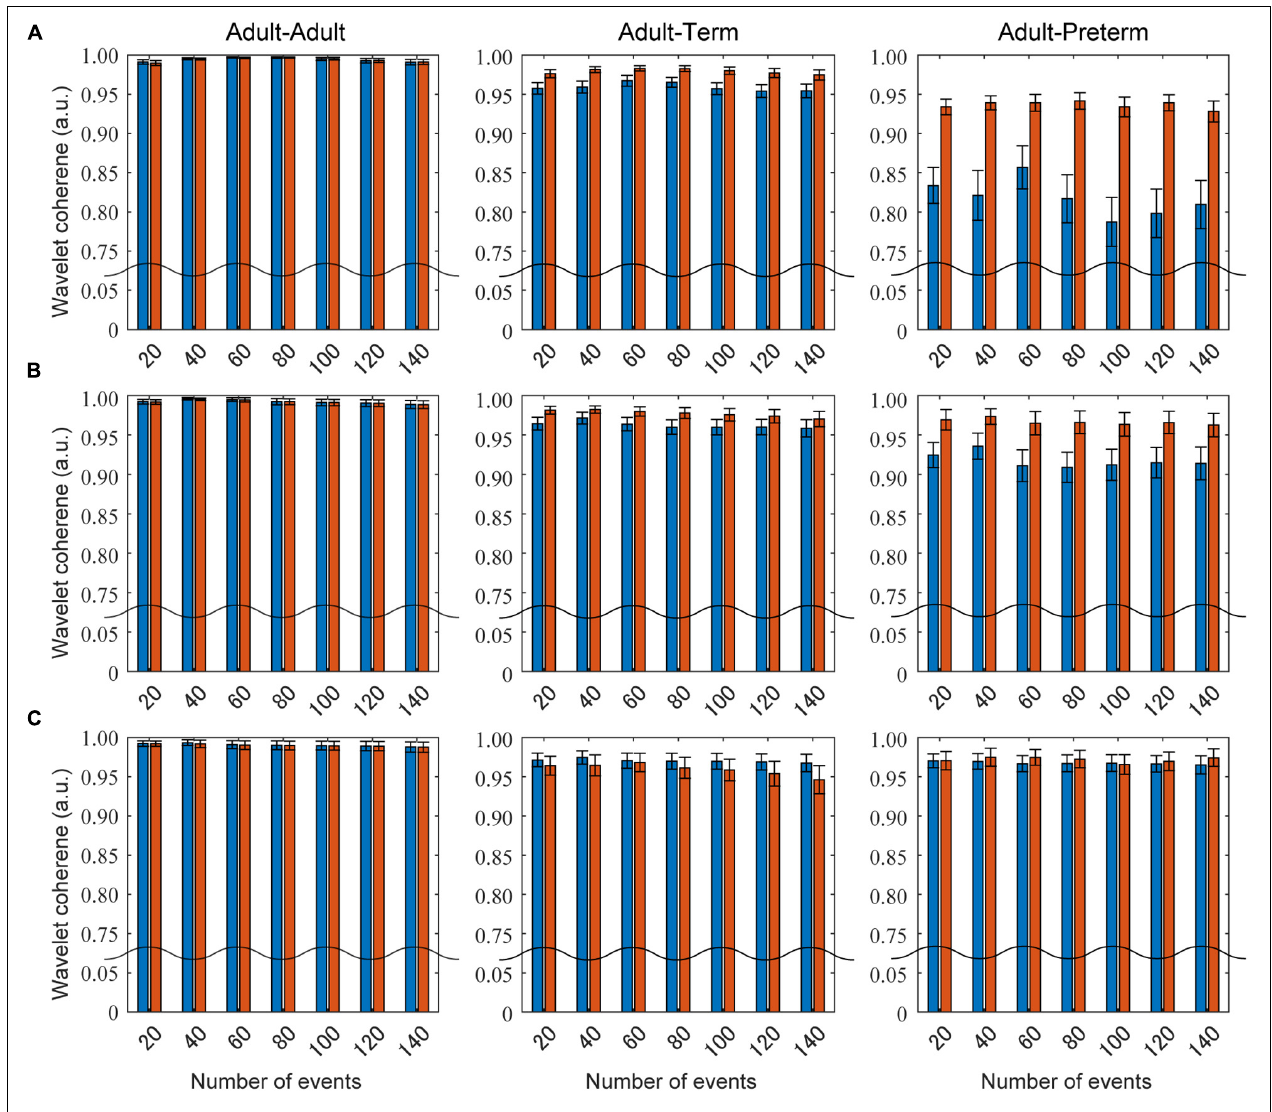
FIGURE 5 | The influence of the number of social events on wavelet coherence. Blue bars show the mean coherence without prewhitening, and red bars indicate that with prewhitening. Panels (A–C) are the results at the 0.086, 0.048, and 0.030 Hz frequency bands, respectively.